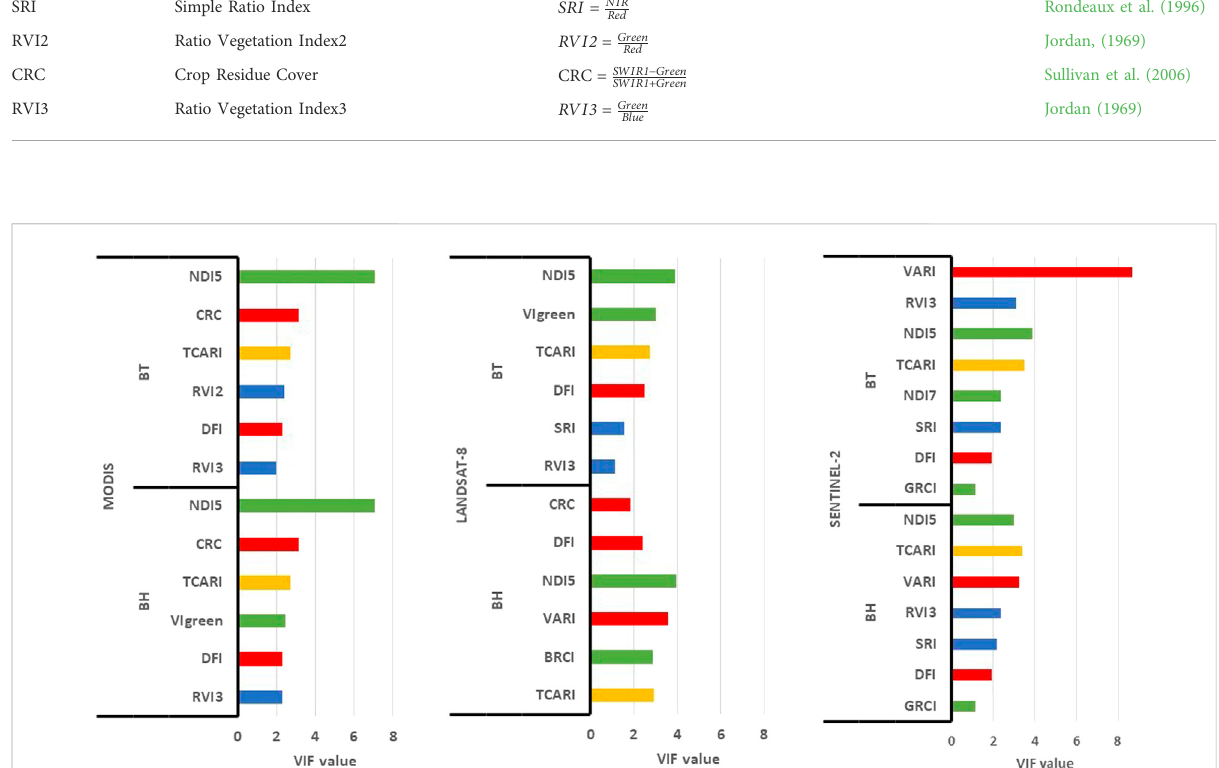
FIGURE 3 Selected explanatory variables after performance and collinearity tests. The included variables are colored as follows: vegetation indices by normalized difference (green), chlorophyll detection indices (yellow), vegetation indices with correction for atmospheric or soil effects (red), and vegetation indices by the ratio